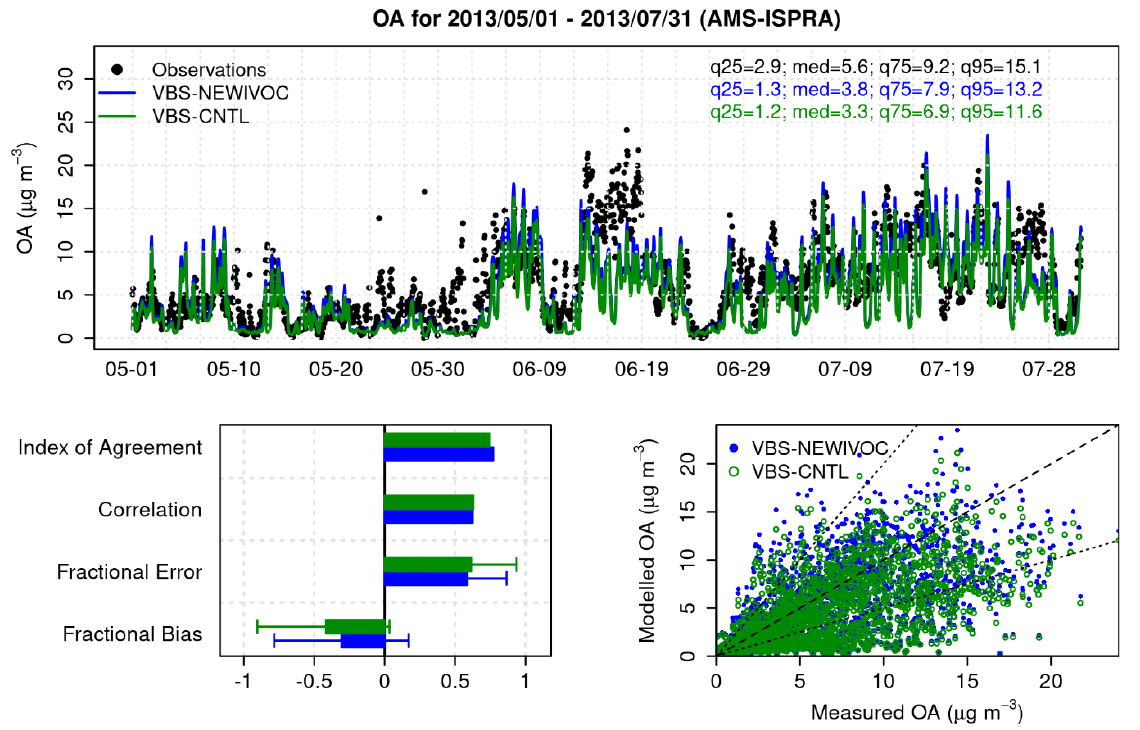
Figure 1. Comparison among modeled and observed (black) OA concentrations in May – July 2013 at the Ispra site: VBS base scheme (VBS-CNTL, green) and VBS scheme with new parameterizations for IVOC emissions (VBS-NEWIVOC, blue).